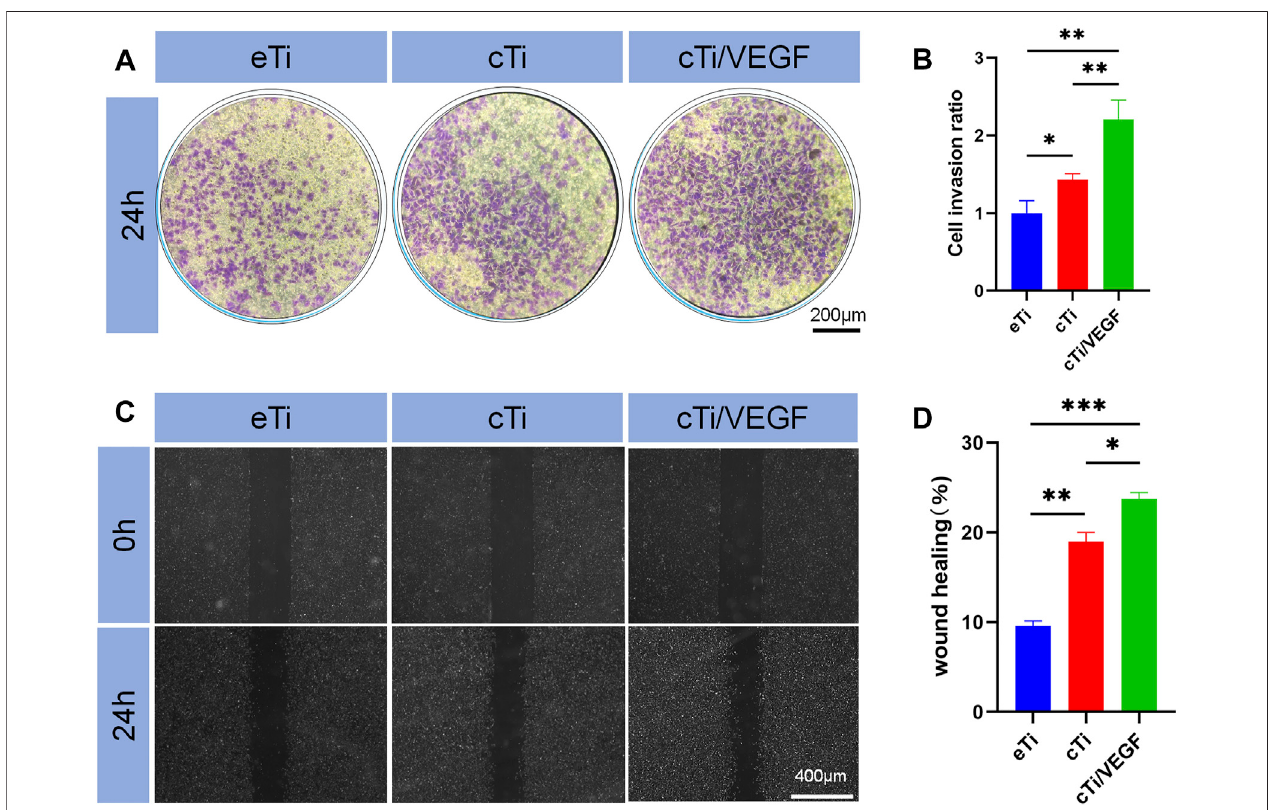
FIGURE 3 | (A) Effects of eTi, cTi, and cTi/VEGF on HUVECs invasion (B) HUVECs stained with crystal violet were quantitatively analyzed (n (cid:1) 3) (C) The effects of eTi, cTi, and cTi/VEGF on wound healing, as observed under a phase contrast microscope (D) Assessment of wound healing rates (n (cid:1) 3).